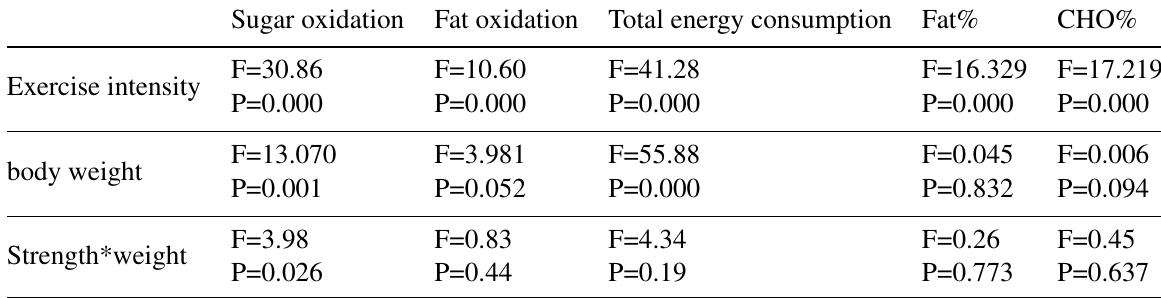
Table 4 Two-factor analysis of variance results of the influence of exercise intensity and body weight on substrate metabolism and energy